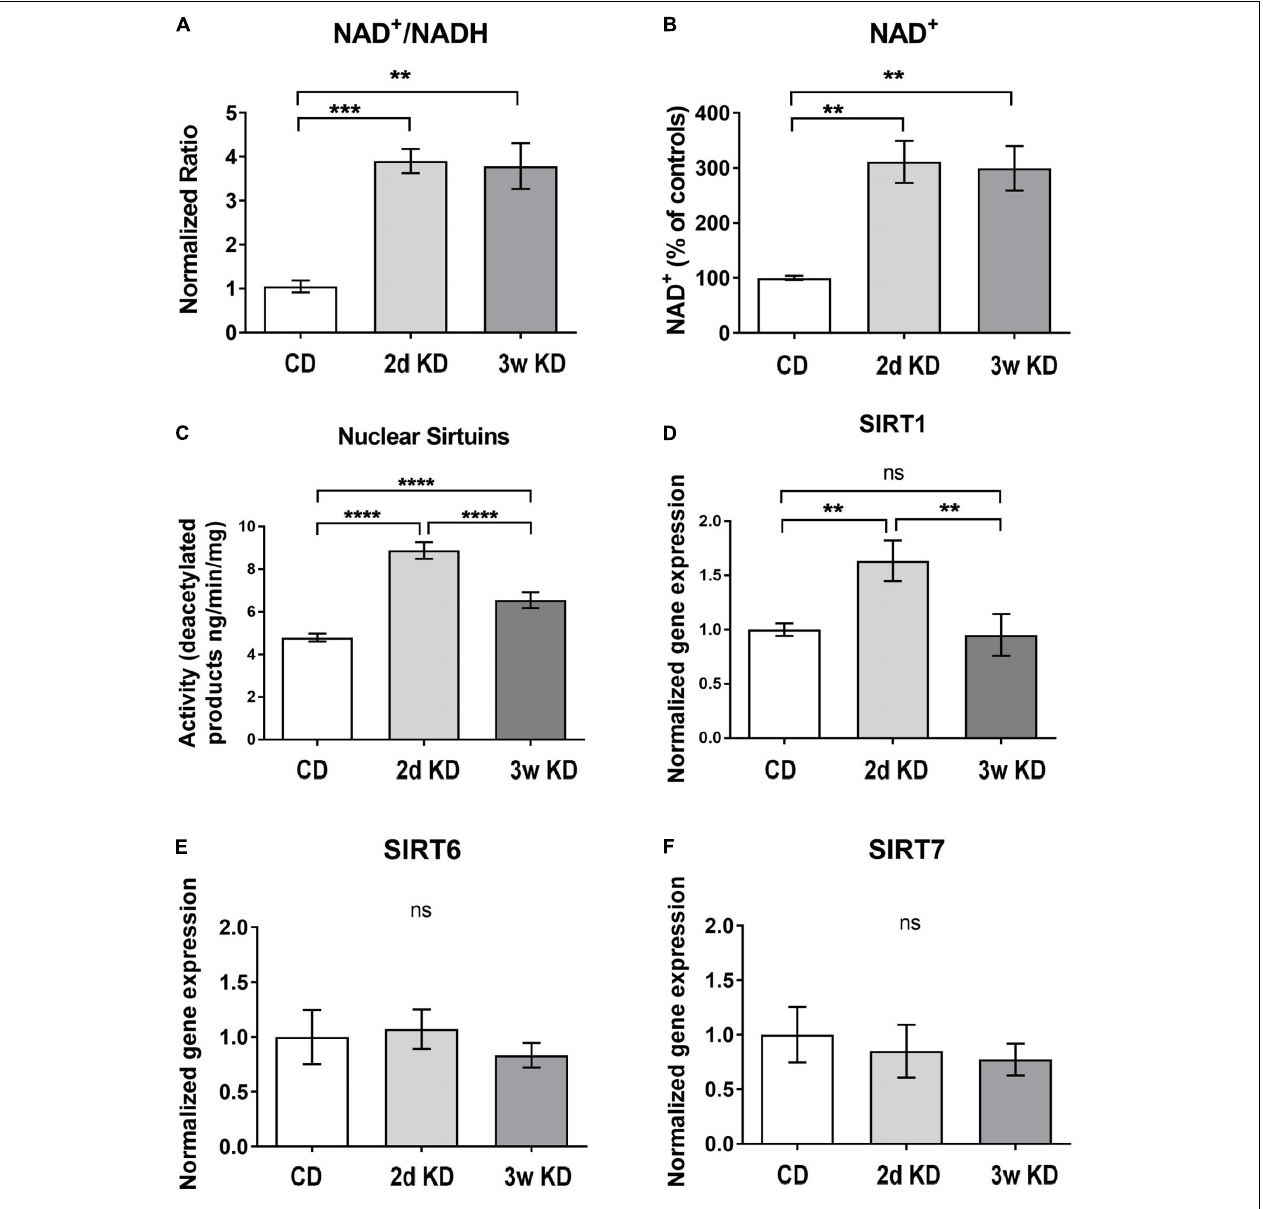
FIGURE 1 | Hippocampal changes in NAD and sirtuins after ketogenic diet (KD) treatment. (A,B) NAD + /NADH ratios and NAD + levels in the hippocampus after standard chow diet (CD; n = 5), 2 day (2d; n = 7), or 3 weeks KD treatment (3w; n = 7). (C) Collective deacetylation activity of Sirt1, Sirt6, and Sirt7 enzymes. A significant increase was observed at 2d and remained elevated at 3w. n = 6–8 animals ( n = 2 per animal). (D–F) Real-time PCR analysis of Sirt1,–6,–7 gene expression in hippocampus. Sirt1 expression was increased only at 2d of treatment. CD, n = 6; 2d KD, n = 8; 3w KD, n = 8 ( n = 2 per animal).